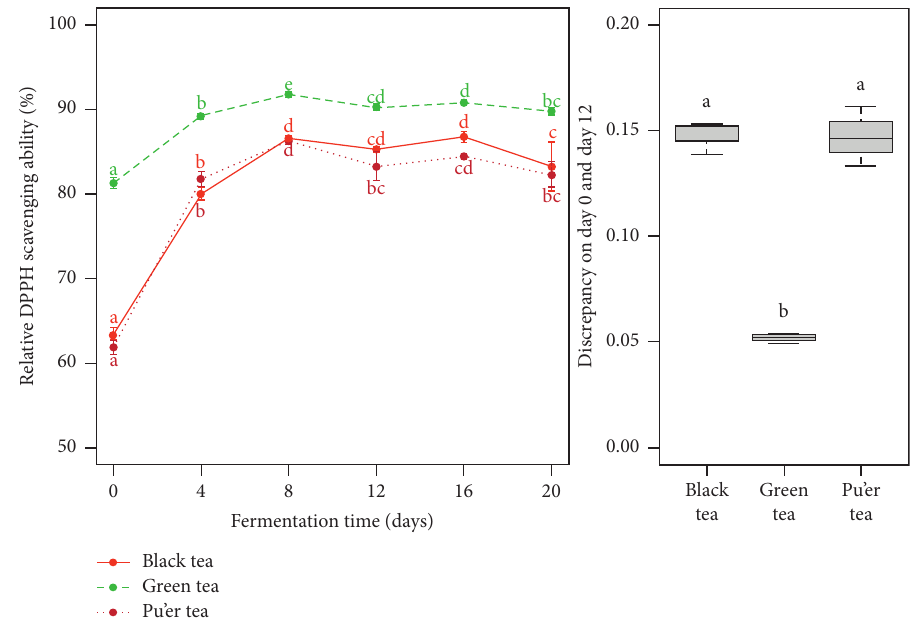
Figure 5: Antioxidant activity assayed using the 2,2-diphenyl-1-picrylhydrazyl radical (DPPH) method (a) and discrepancy value (b) during fermentation of kombucha prepared from green, black, and pu’er teas. Different letters indicate significant differences between the tea groups ( p < 0 .